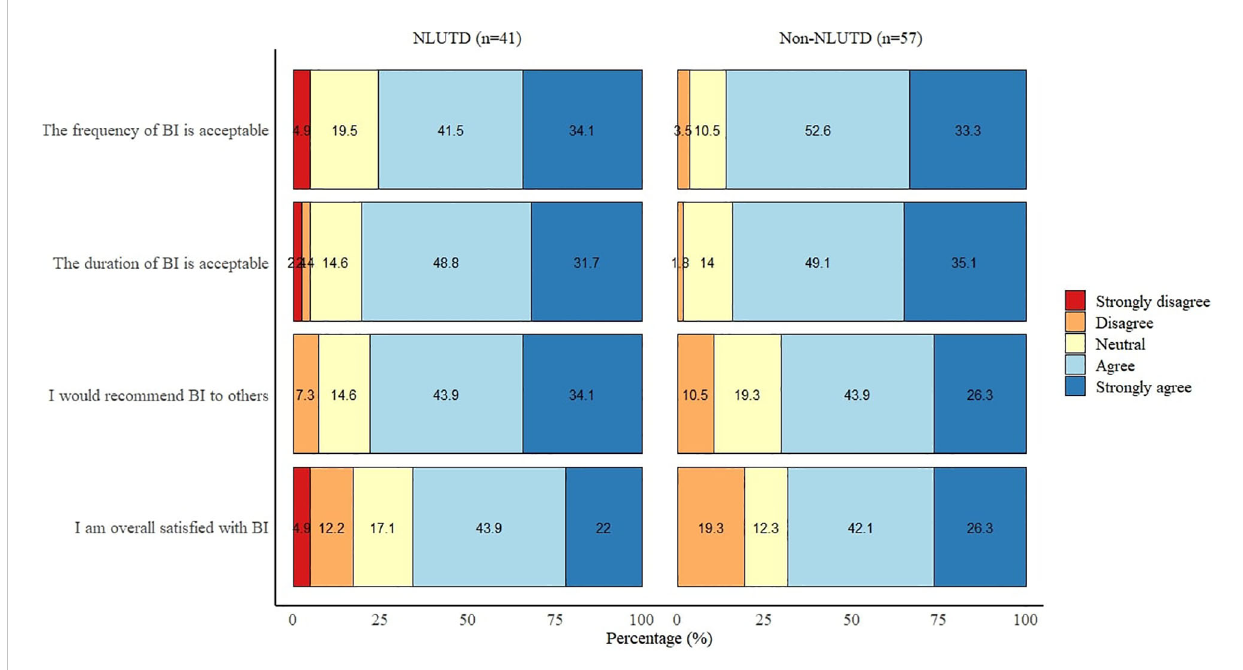
FIGURE 2 Treatment satisfaction outcomes of bladder irrigation with tap